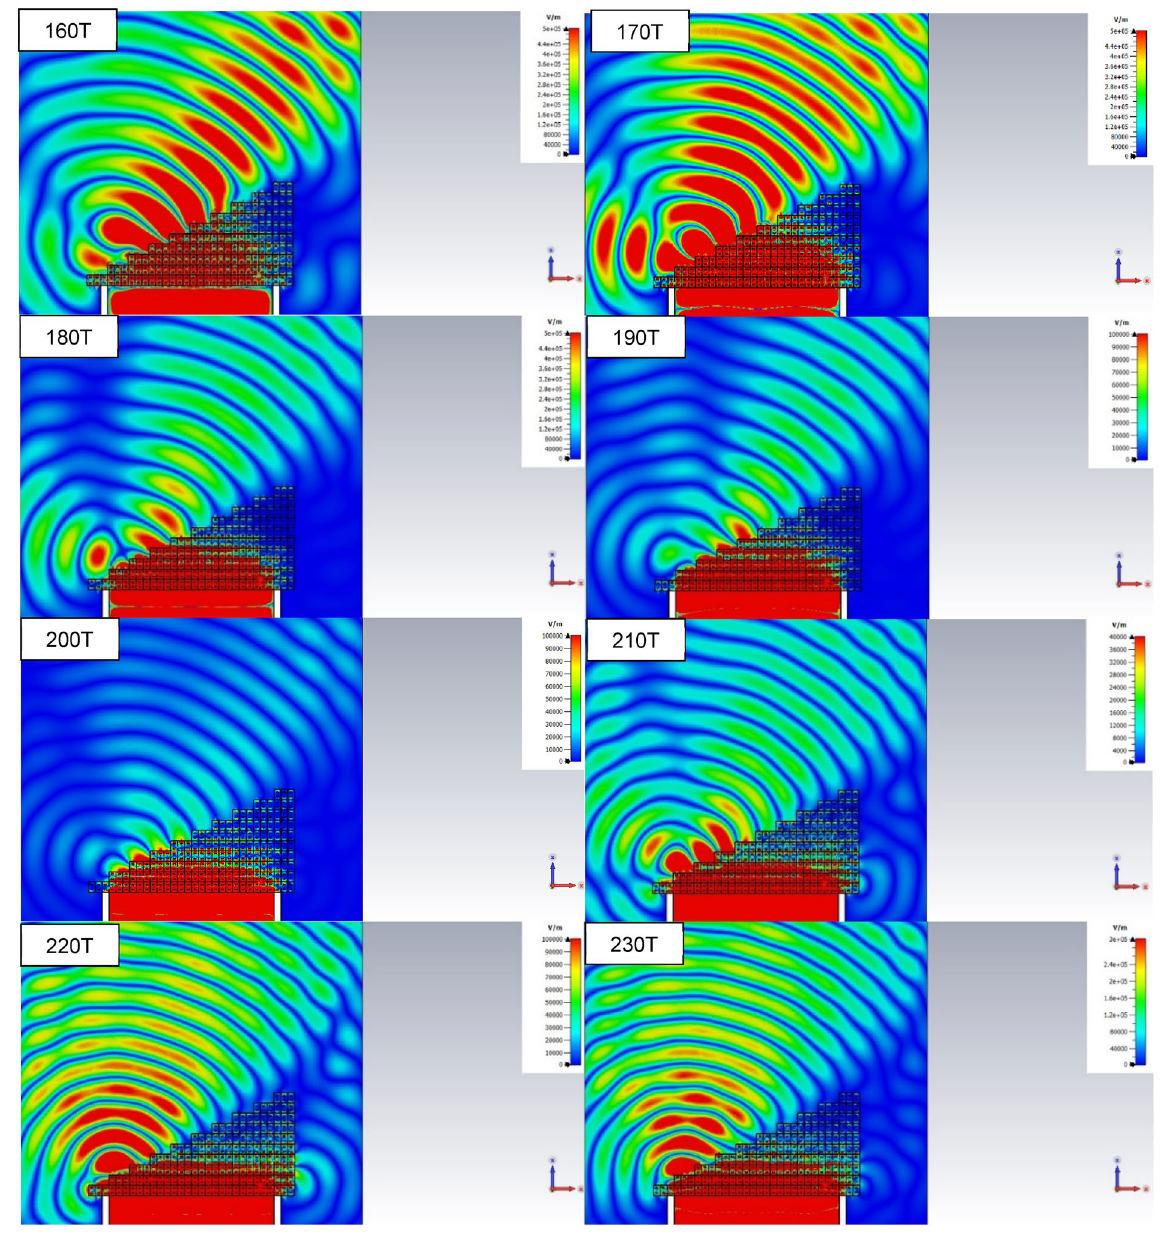
Figure 11. Absolute value of the electric field within and around a prism made of Chan et al.’s metamaterial for various frequencies when a plane wave is incident upon it, based on a numerical simulation. The shape of the prism is delineated for clarity for the first frequency. Generated using CST Microwave Studio 30